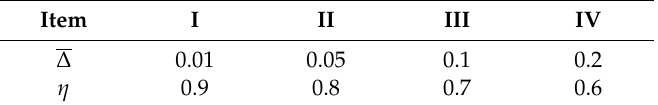
Table 2. Definition of critical values and their error